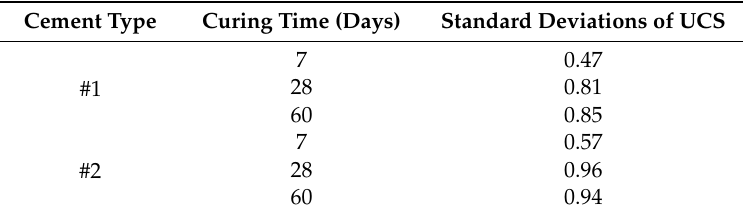
Figure 3. CPB specimen and its UCS test: ( a ) Prepared specimen; ( b ) UCS tests. Table 6. The standard deviations of UCS test